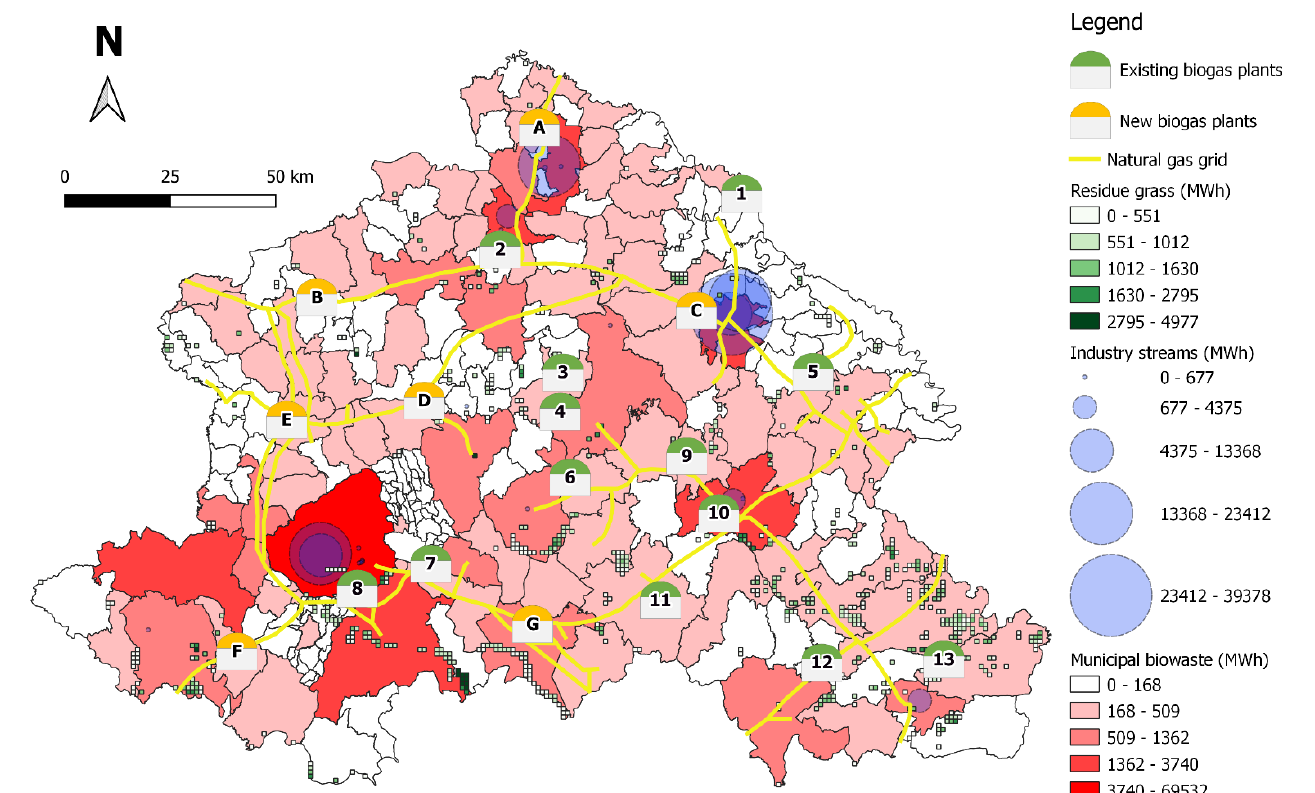
Figure 2. Geospatial analysis of the biogas sector in Northern Croatia.